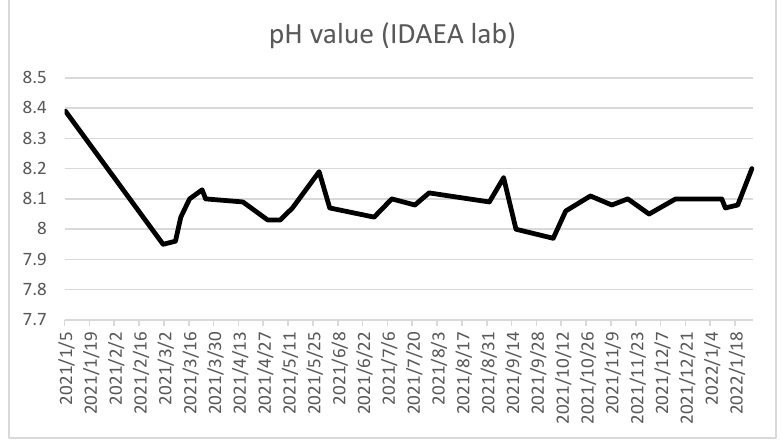
Figure 5. IDAEA pH results from the South basin Barcelona port water. Source: The authors.